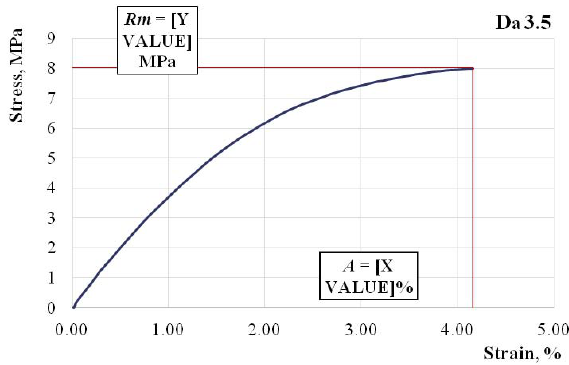
Figure 6. The characteristic curve of a Da 3.x representative sample.